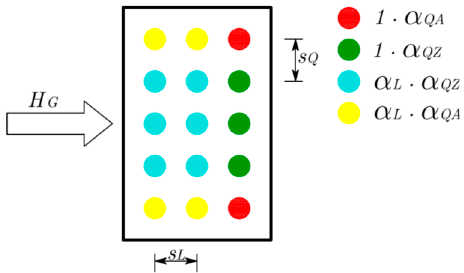
Figure 2. Determination of pile interaction factors based on the pile position inside the pile group (after Kotthaus [50]). s L and s Q denote the pile center-to-center spacings in the direction of the lateral loading H G , and perpendicular to the direction of the lateral loading, respectively. Four different pile types, based on the pile position inside the pile group, are distinguished and associated with four different colors.